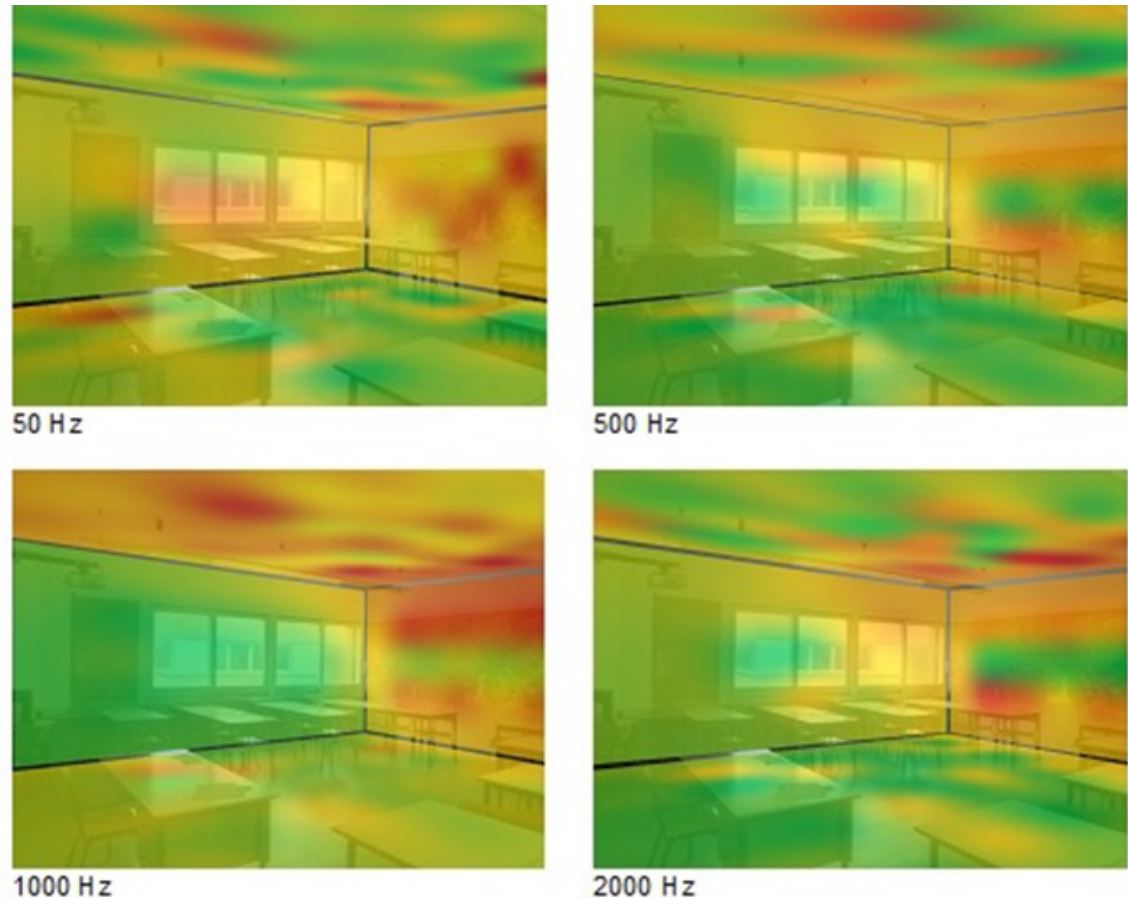
Figure 7: Solid Noise vibration mapping results for 1/3 octave band analysis in the F classroom of school S2. The scale is different for each frequency band: absolute values are higher at lower